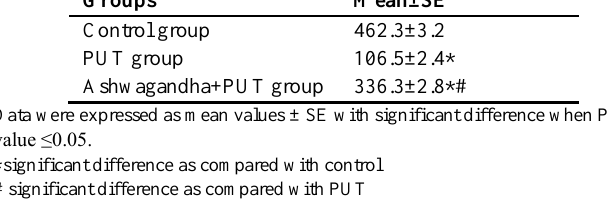
Table 3: Mean±SE area% and optical density of PAS reaction in thyroid gland and bone respectively in the studied groups Area% of PAS reaction in thyroid gland Optical density